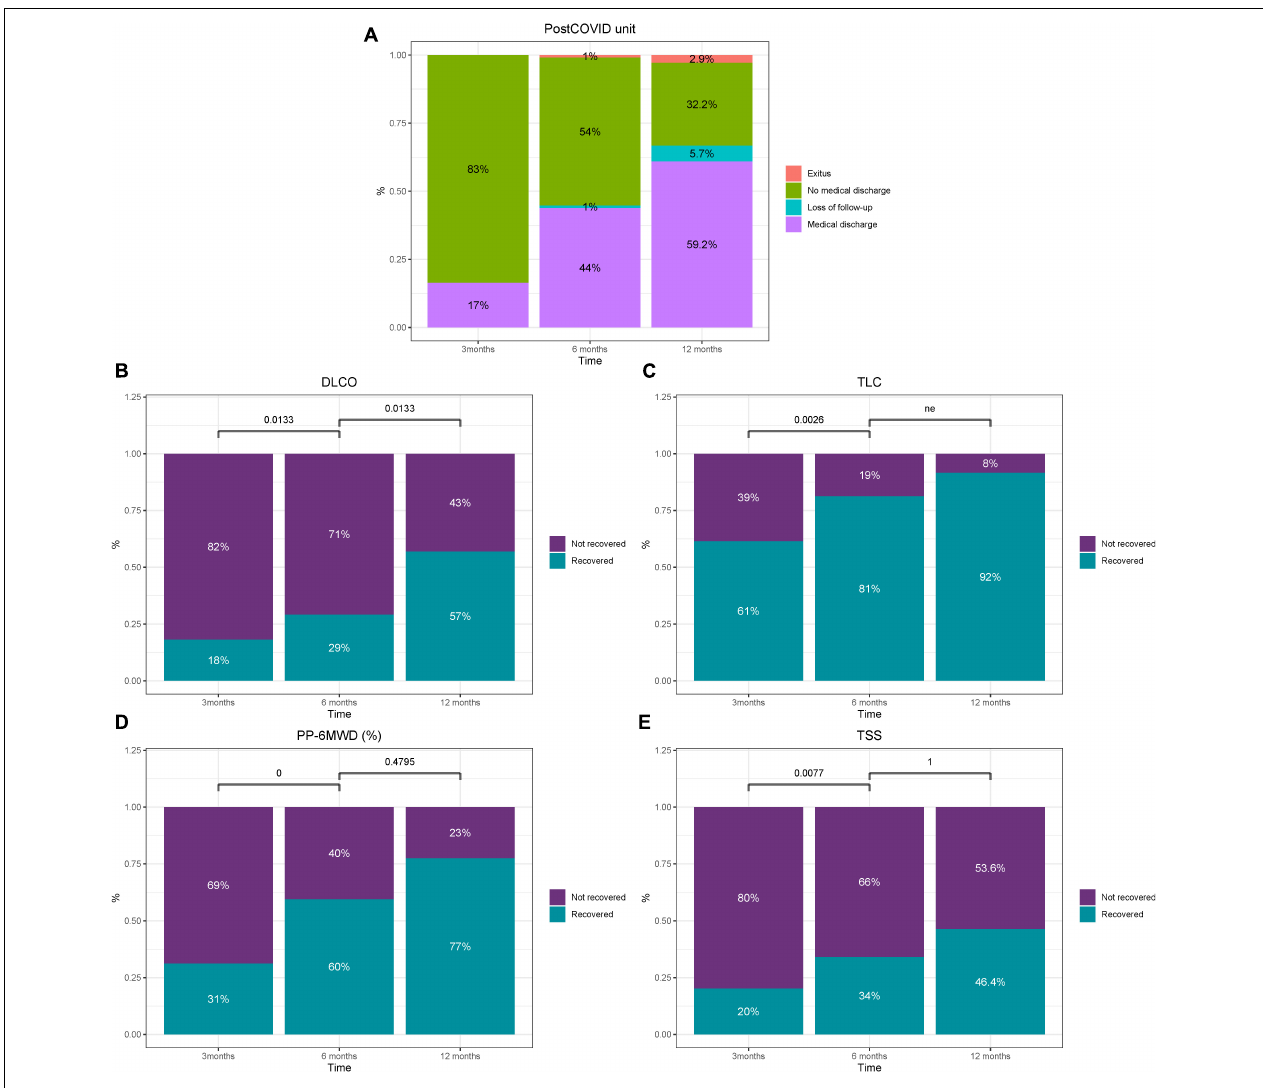
FIGURE 2 | Overview of clinical decisions and percentage of recovered patients regarding post-COVID unit (A) , DLCO (B) , TLC (C) , 6MWT (D) , and TSS (E) over time. P -values were computed using McNemar’s test. ne, not estimable.